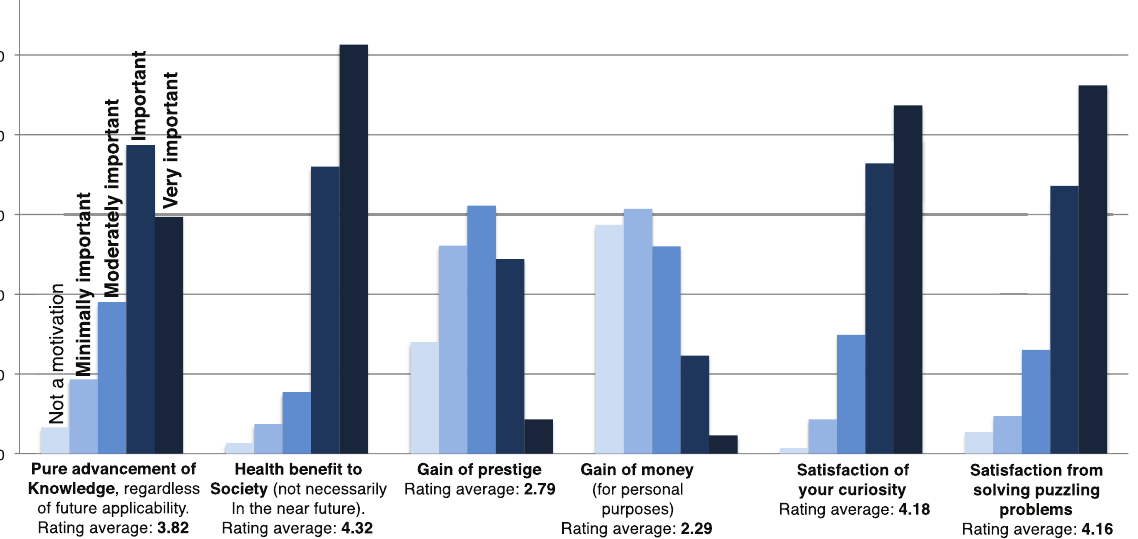
Figure 3. What does motivate the basic scientists? ( A ) Graph shows the responses of the surveyed scientists to the following input: “the motivation of MOST basic biological/biomedical scientists are from:”. Six different types of motivations were proposed. Respondents could rate each type of motivation as “not a motivation, “minimally important”, “moderately important”, “important” or “very important”. Rating averages for each type of motivation are also indicated (the scores were 1 to 5, from “not a motivation” to “very important”). 299 respondents answered the question; 5 skipped. ( B ) Graph shows the responses to the following input: “YOUR personal motivations as a scientist are from:”. Six different types of motivations were proposed. Respondents could rate each type of motivation as “not a motivation, “minimally important”, “moderately important”, “important” or “very important”. Rating averages for each type of motivation are also indicated (the scores were 1 to 5, from “not a motivation” to “very important”). 302 respondents answered the question; 2